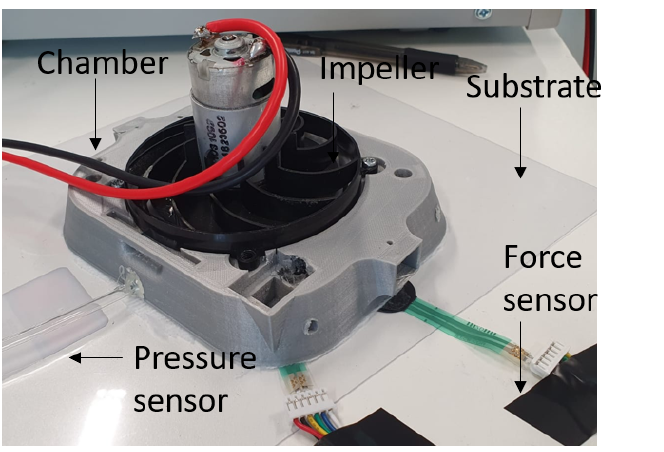
Figure 15. Experimental set up for pressure and contact force